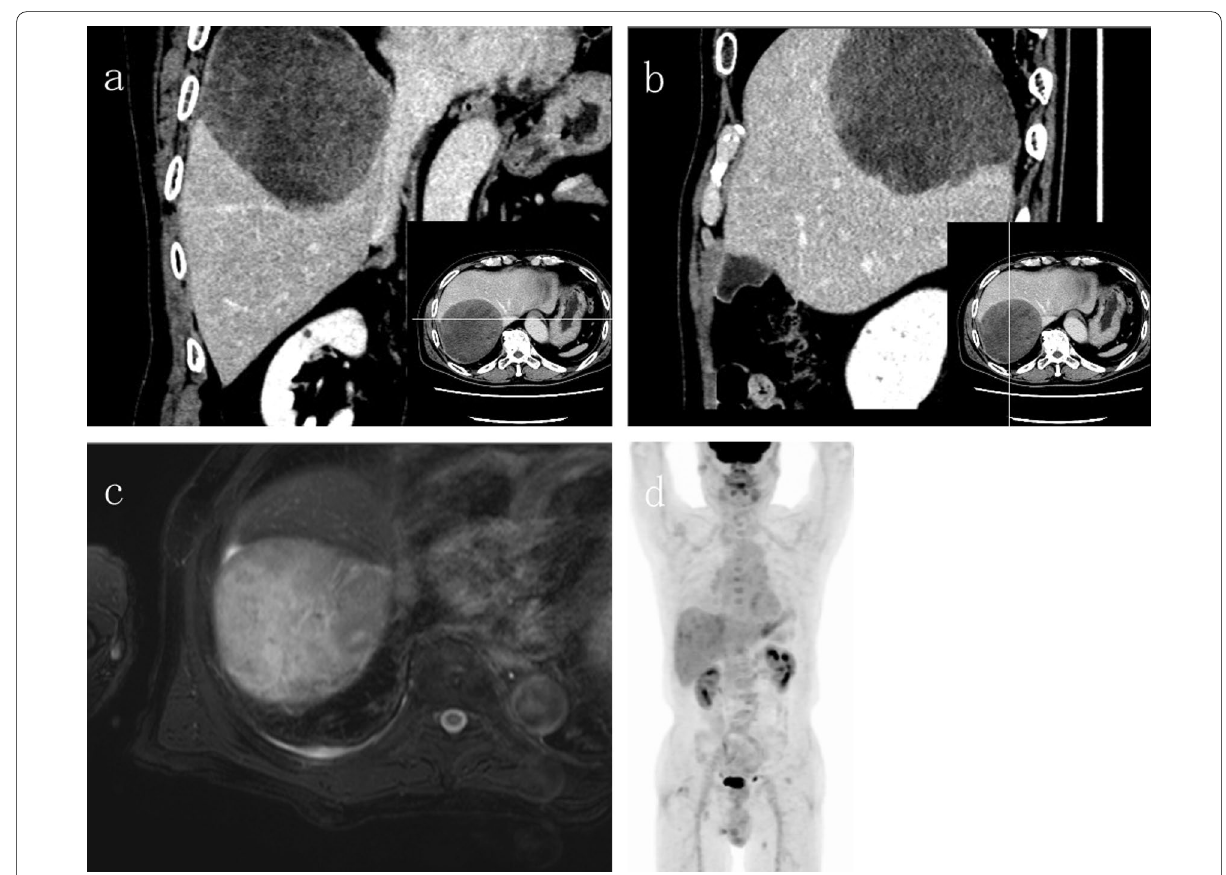
Fig. 1 Contrast‑enhanced computed tomography (CT), contrast‑enhanced magnetic resonance imaging (MRI), and positron emission tomography (PET). a , b CT shows a well‑circumscribed and smooth‑marginated, huge 10‑cm mass under the right diaphragm. The main feeder for the tumor is the right inferior phrenic artery. c MRI demonstrates heterogeneous high signal intensity on T2WI. d PET revealed abnormal uptake in the tumor with a SUVmax of